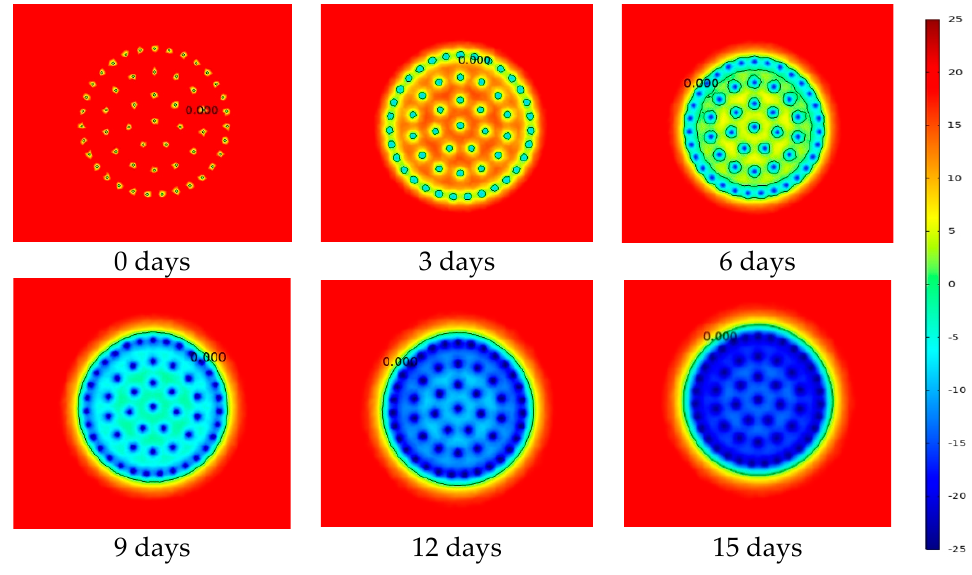
Figure 9. Temperature cloud map in Section 2.